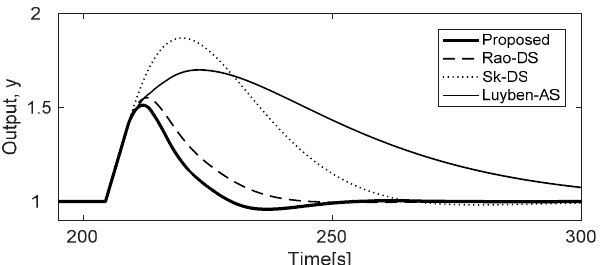
Figure 7. Regulatory responses to disturbance in PIPTD with − 10% parameter mismatch.